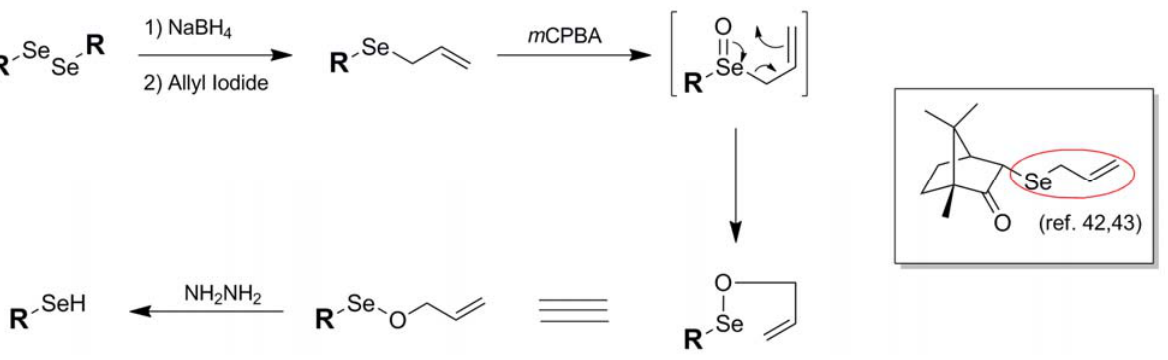
Figure 9. Installation and deprotection mechanism of Se-Allyl-based protection